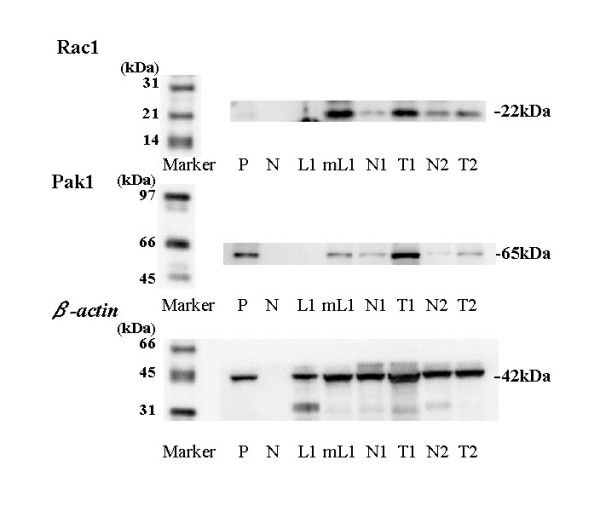
Expression of GTP-binding (active form) Rac1 (22 kDa), Pak1 (65 kDa) and beta actin (42 kDa) proteins using Western blotting. M; marker, P; positive control using Hela cells, N; negative control, T1,2; tumor tissue, N1,2; non-tumor tissue. LN1; non-tumor lymph node, mLN1; metastatic lymph node, Each number corresponds to a case number.